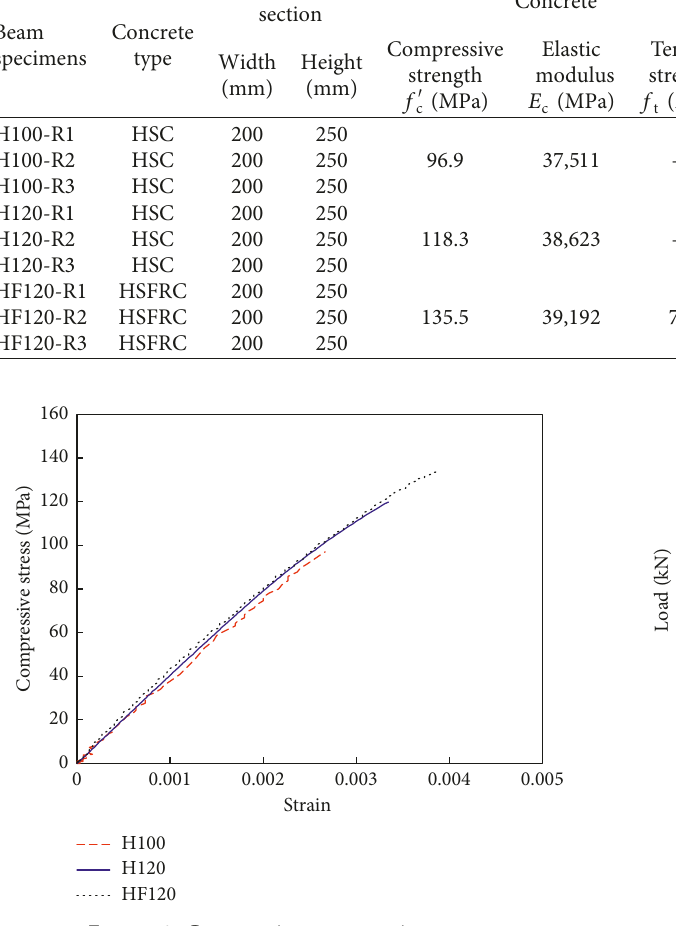
Figure 2: Compressive stress-strain curves. Figure 3: Load-CMOD relationship